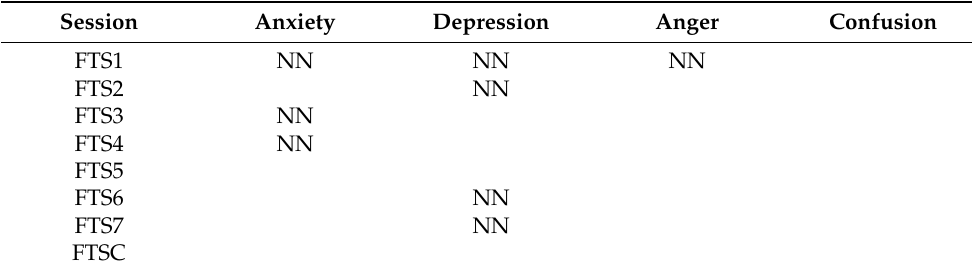
Table 5. Results of the Ryan–Joiner test for normality of change-from-baseline for any mood state in any forest therapy session. NN = non-normal; all other distributions were